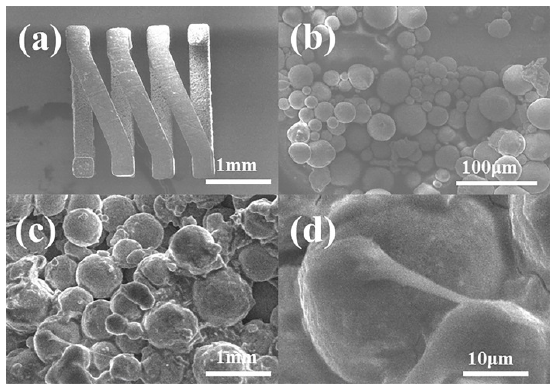
Figure 8. ( a ) Overall structure after removing the silicon substrate; ( b ) pre-alloyed powder before sintering; ( c ) after sintering; and ( d ) adhesion between particles after sintering.